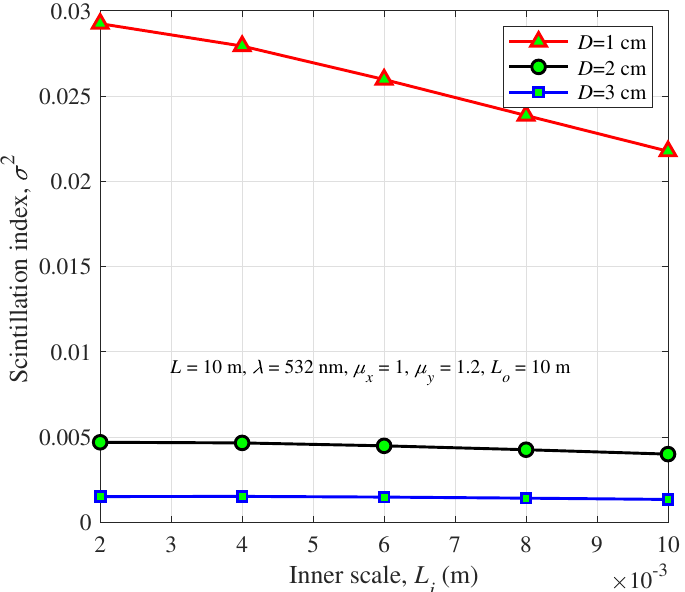
Figure 5. Scintillation index of a spherical wave versus the inner scale for different aperture diameters.